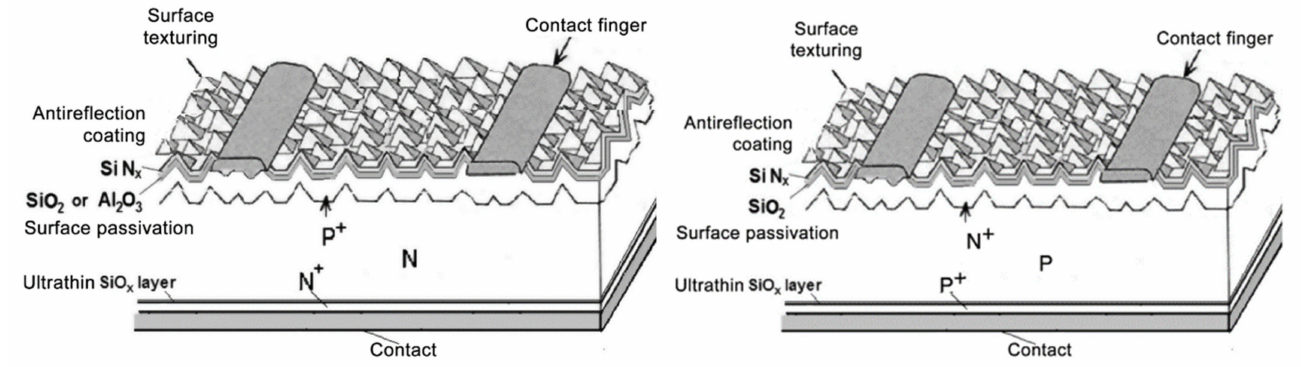
Figure 11. TOPCon structure.